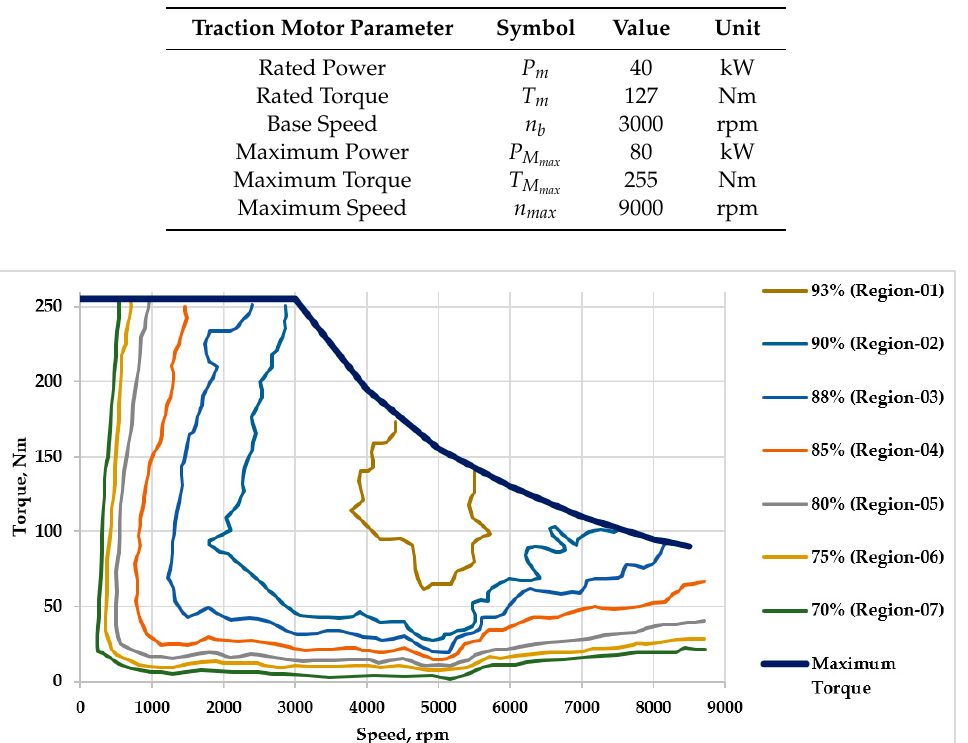
Figure 1. Maximum torque capacity and efficiency maps of the motor [8].